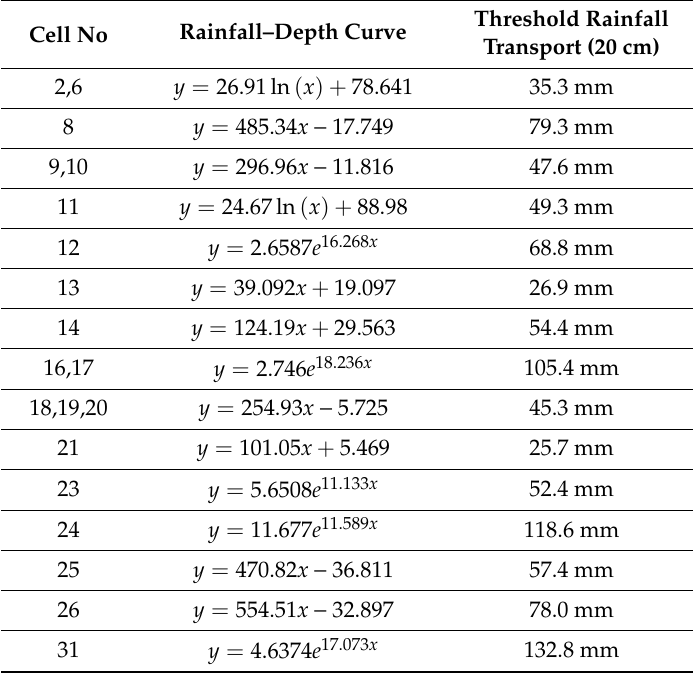
Table 2. Threshold rainfall of each cell.